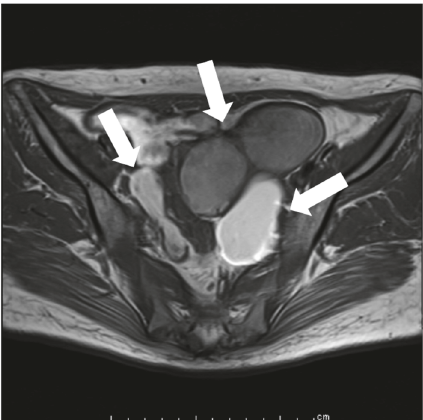
Figure 3: Posttreatment magnetic resonance imaging of our patient with endometriosis. MRI after eight years of treatment. The right ovary shows a mass with a maximum diameter of 114 mm (arrow). The solid part of the mass exhibits a low-intensity